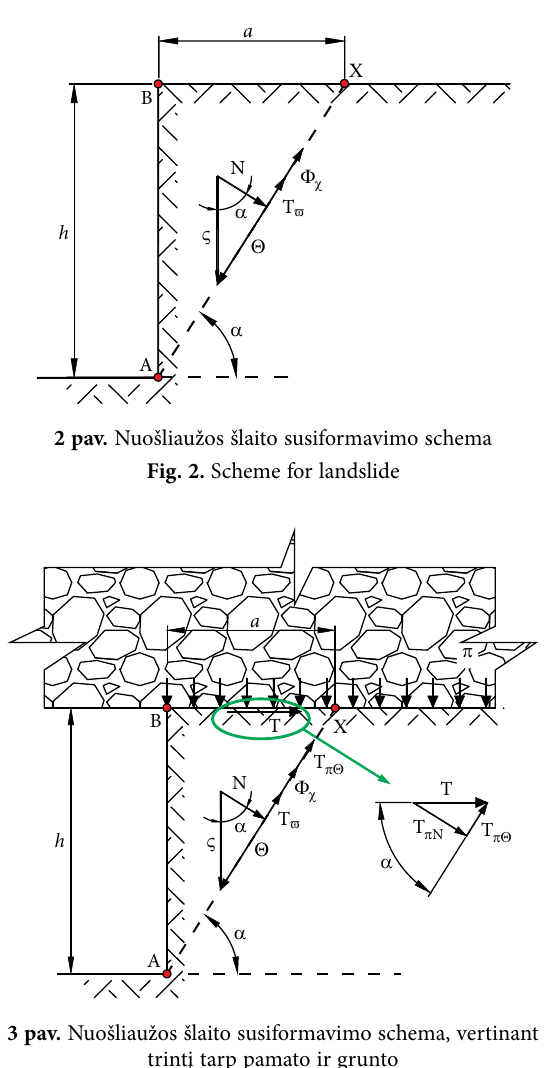
trintį tarp pamato ir grunto Fig. 3. Scheme for landslide evaluating friction between foundations and soil